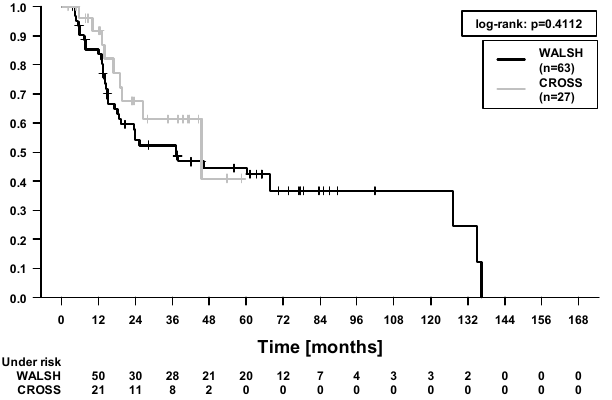
Figure 2. Progression-free survival (PFS). Comparison between patients treated with carboplatin/paclitaxel (‘CROSS’) and patients treated with 5-fluorouracil/cisplatin (‘WALSH’).